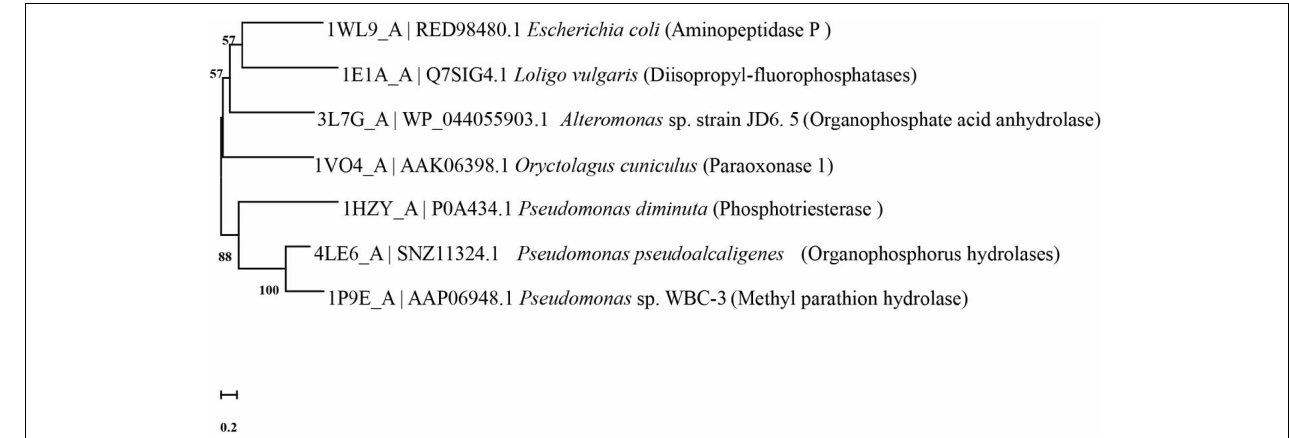
FIGURE 4 | Phylogenetic tree of key diazinon-degrading enzymes constructed by the neighbor-joining method. The code before the strain name is the NCBI accession number. Aminopeptidase P was isolated from Escherichia coli (Graham et al., 2005). Diisopropyl-fluorophosphatase was isolated from Loligo vulgaris (Scharff et al., 2001). Organophosphate acid anhydrolase was isolated from Alteromonas sp. strain JD6.5 (Vyas et al., 2010). Paraoxonase 1 was isolated from Oryctolagus cuniculus (Thakur et al., 2019). Phosphotriesterase was isolated from Pseudomonas diminuta (Benning et al., 2001). Organophosphorus hydrolase was isolated from Pseudomonas pseudoalcaligenes (Gotthard et al., 2013). Methyl parathion hydrolase was isolated from Pseudomonas sp. WBC-3 (Dong et al., 2005).